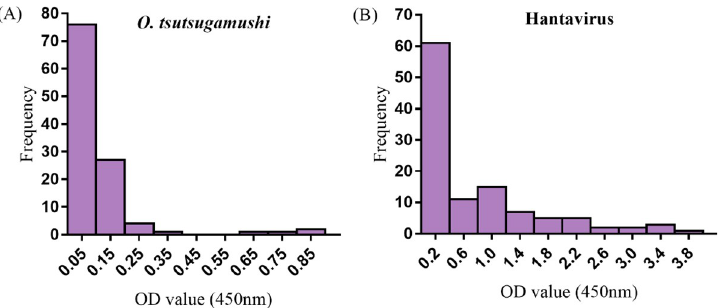
Fig 2. Frequency distribution of the OD values in ELISA. (A) Distribution of the OD values for IgM antibody to O . tsutsugamushi . Cut-off: 0.1960. (B) Distribution of the OD values for IgM antibody to hantavirus. Cut-off: